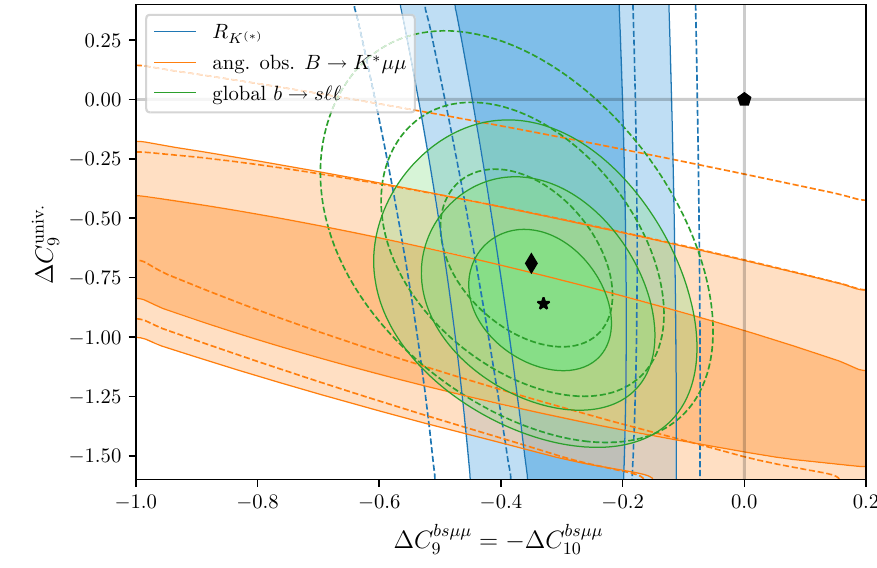
Fig. 1 Likelihood contours for the b → s (cid:4)(cid:4) -data in the plane spanned lihood contours, without the inclusion of the recent LHCb measure- μμ ment. In addition to the angular observables and R K ( ∗ ) , the “global” by (cid:10) C bs , corresponding to the scenario 9 contour (green regions) includes all other b → s (cid:4)(cid:4) data as listed in withthelargest p -value(seeTables1and2).Theshadedregions(delim- Appendix B.1. The black pentagon denotes the SM-value, while the ited by full lines) correspond to the 1 , 2 ( 3 )σ regions around the best-fit star (diamond) denotes the best-fit point to the current (old) point including the recent data; the dashed lines denote the same like-